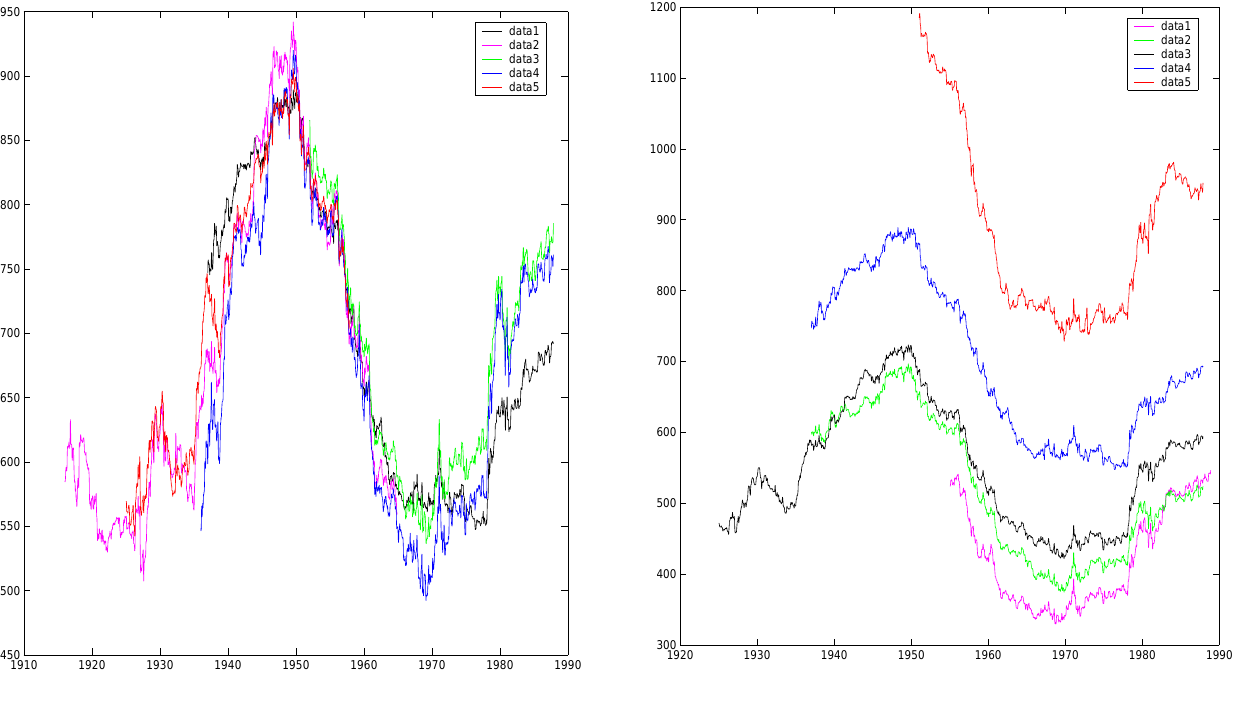
Fig. 3. Amplitude of the 6-month line, A 6 (t) , for (1) LER (2) HER (3) HON(4) KAK (5) TUC. X component. Vertical unit: .35 10 − 3 nT/day.